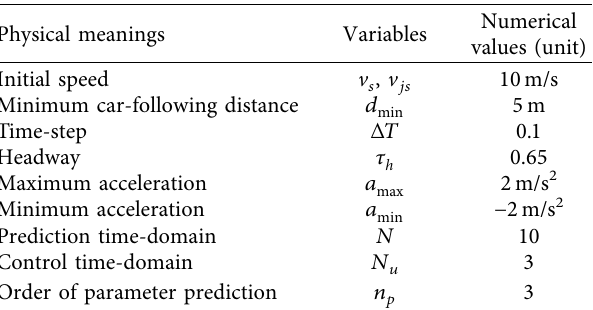
Figure 2: Joint simulation platform architecture. Table 4: System key parameters setting [24,